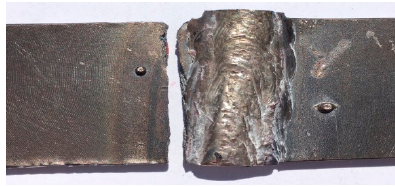
Figure 8. Type of sample failure found during tensile tests; failure due to initial rupture in the HAZ area.